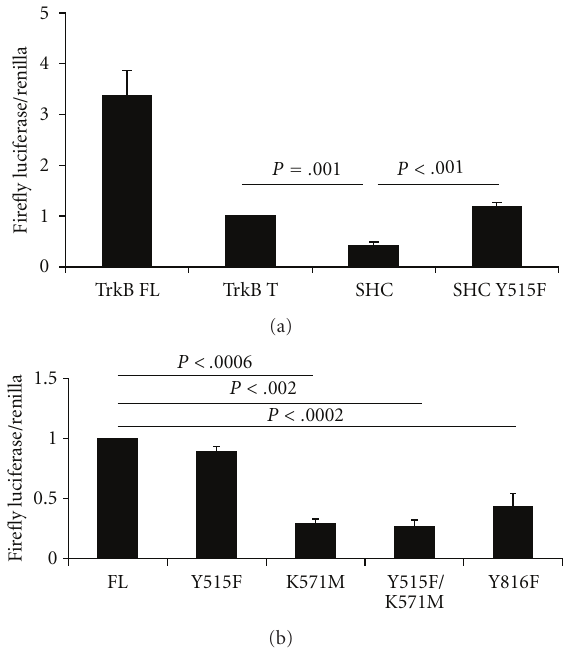
Figure 3: Mutation of TrkB FL intracellular functional domains changes the e ff ect on AICD-mediated luciferase activity. (a) The TrkB SHC isoform significantly decreases luciferase activity when compared to TrkB T ( P = . 001). The TrkB SHC Y515F mutant, unable to bind SHC, increases luciferase activity compared to TrkB SHC ( P < . 001) and does not significantly alter luciferase activity compared to TrkB T ( P = . 1). (b) TrkB Y515F (no SHC-binding) does not significantly alter luciferase activity compared to TrkB FL. TrkB K571M with an inactive tyrosine kinase domain significantly decreases luciferase activity compared to TrkB FL ( P = . 0006); TrkB Y515F/K571M significantly decreases luciferase activity compared to TrkB FL ( P = . 002) but not to a greater extent of TrkB K571M. TrkB Y816F that does not bind PLC- γ also significantly decreases luciferase activity compared to TrkB FL ( P = . 0002). 4–8 independent experiments with 6 replicates each, error bars SEM. 4– 6 independent experiments with 6 replicates each, error bars SEM. Statistical analysis: Student’s t -test with Bonferroni